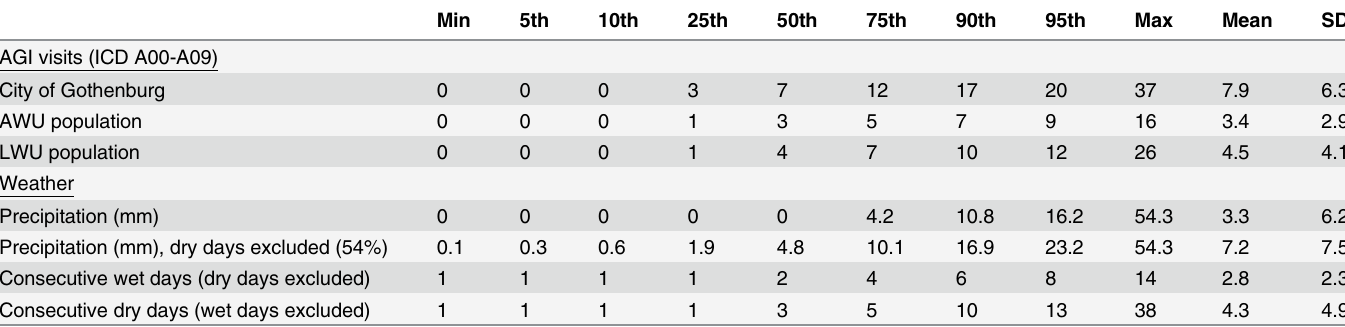
Table 1. Descriptive statistics AGI visits and